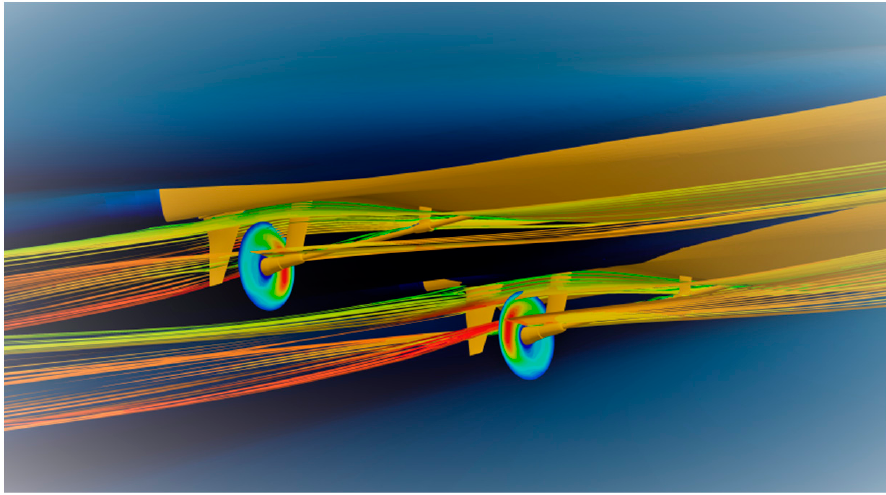
Figure 5. Computed streamlines in the stern tunnels and passing the propellers discs.